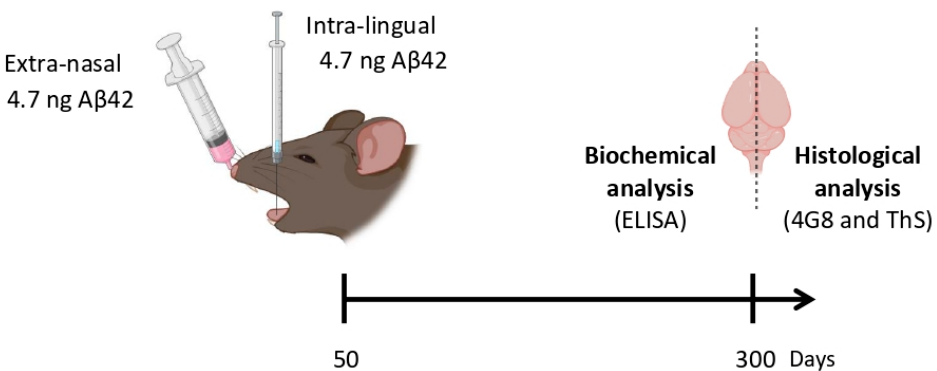
Figure 1. Experimental strategy . 50 ‐ day ‐ old Tg2576 animals were challenged with old Tg2576 ‐ brain homogenate by two different routes, including extra ‐ nasal or intra ‐ lingual. For extra ‐ nasal administration, animals received 5 μ L of BH onto each nostril. For intra ‐ lingual injections, 10 μ L of BH was injected into the tongue. The levels of insoluble A β 42 present in the BH were analyzed by ELISA. The estimated amount of administered A β 42 was 4.7 ng by each route. Animals were sacrificed at the age of 300 ‐ day ‐ old, brains were removed, and histological as well as biochemical analyses were performed.